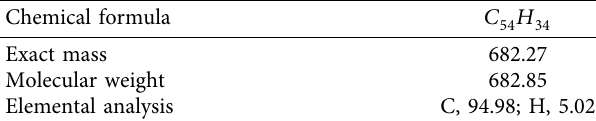
Table 1: Chemical properties of graph G ∗ . Chemical formula